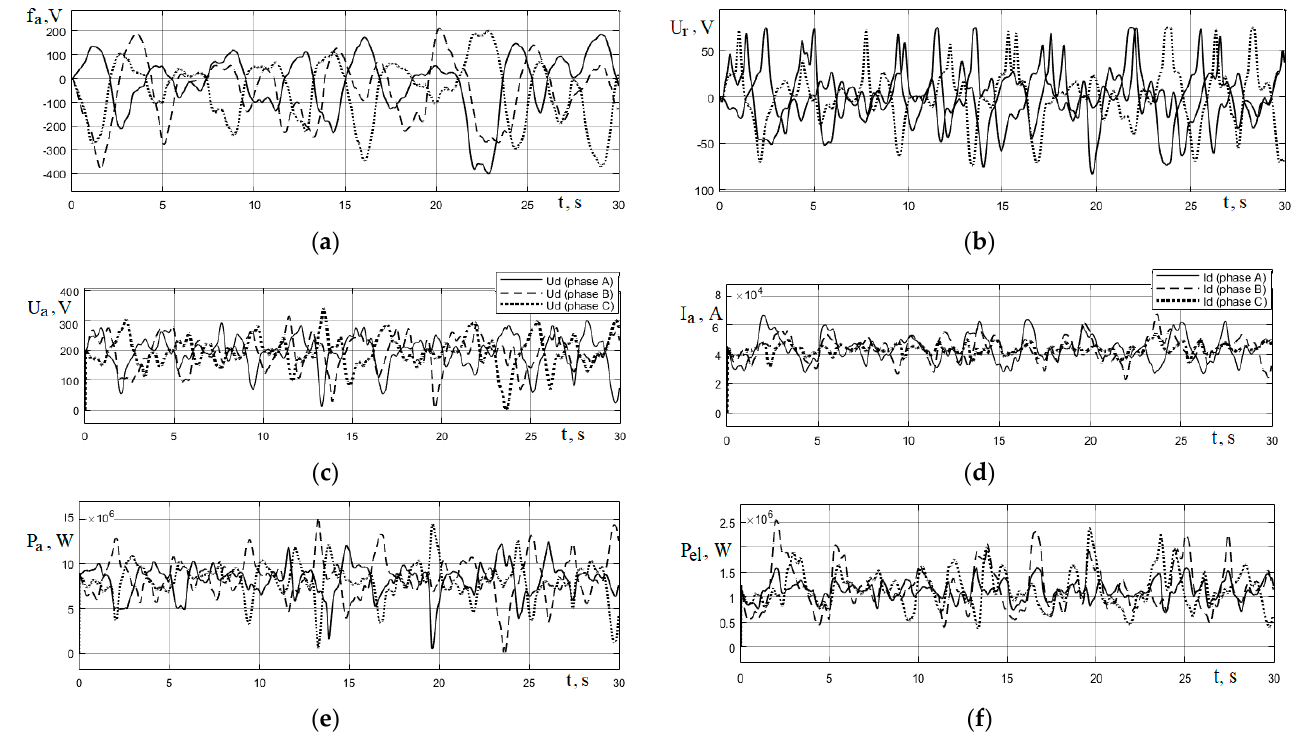
Figure 10. Time dependences of random perturbations: ( a ) mismatch signals; ( b , c ) voltages; ( d ) cur- rents; ( e ) power of arcs; ( f ) power of electric losses when using fuzzy model (6) for energy-intensive regime of melting of wells in a solid charge.